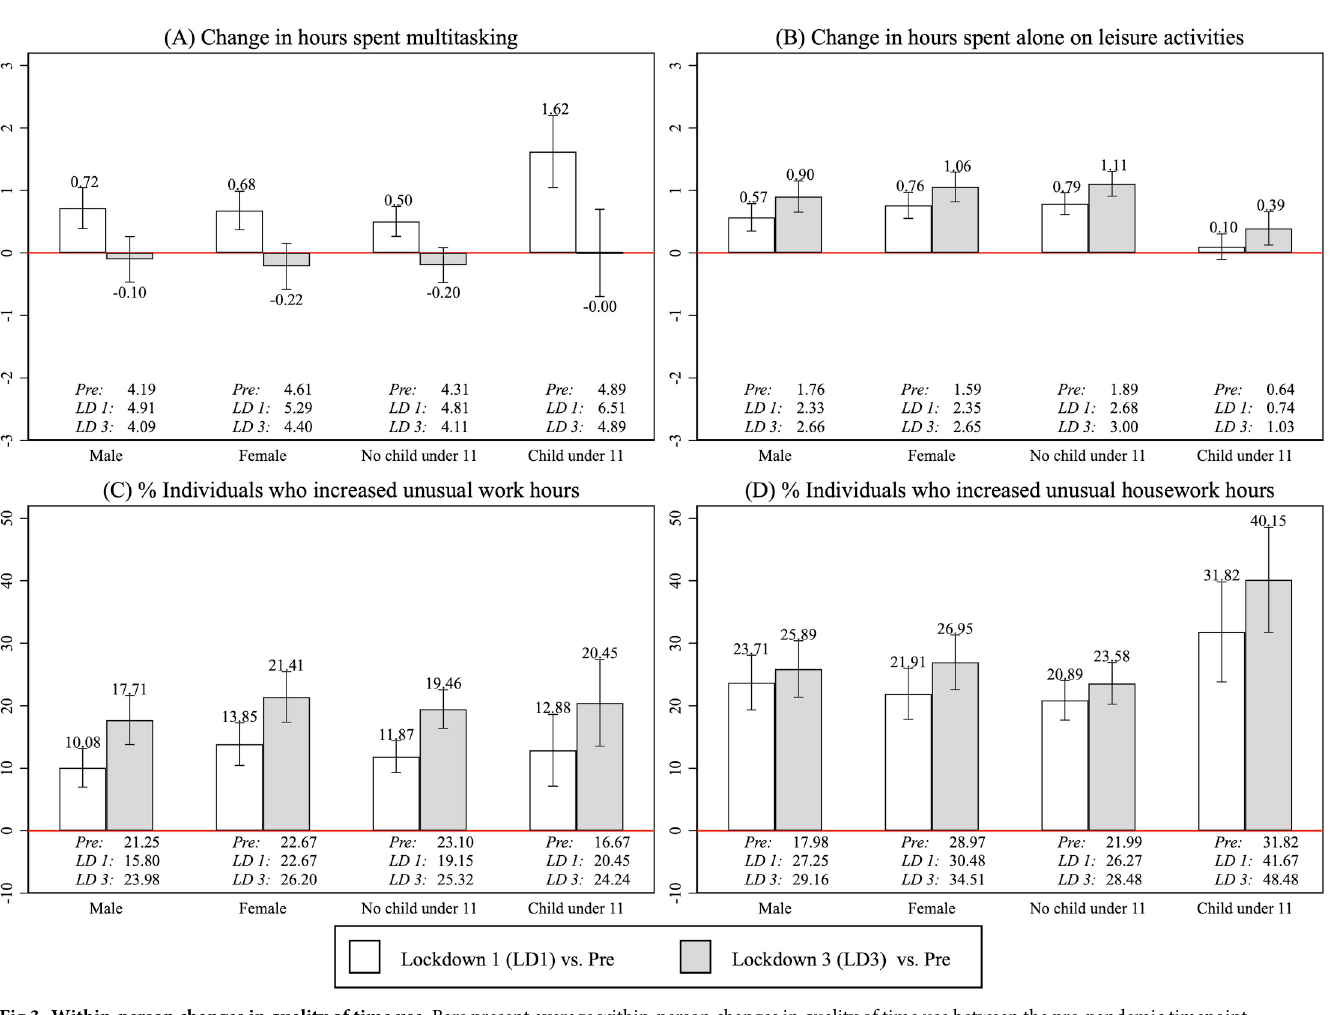
Fig 3. Within-person changes in quality of time use. Bars present average within-person changes in quality of time use between the pre-pandemic timepoint (February 2020) and the first lockdown (May 2020) or the third lockdown (March 2021). Unusual work includes the job searching activities of the unemployed. Error bars represent 95% confidence intervals, and average levels for each subgroup are reported underneath the bars. Note that the conditional means were calculated separately (either by gender or household composition), so the four subgroups shown are not mutually